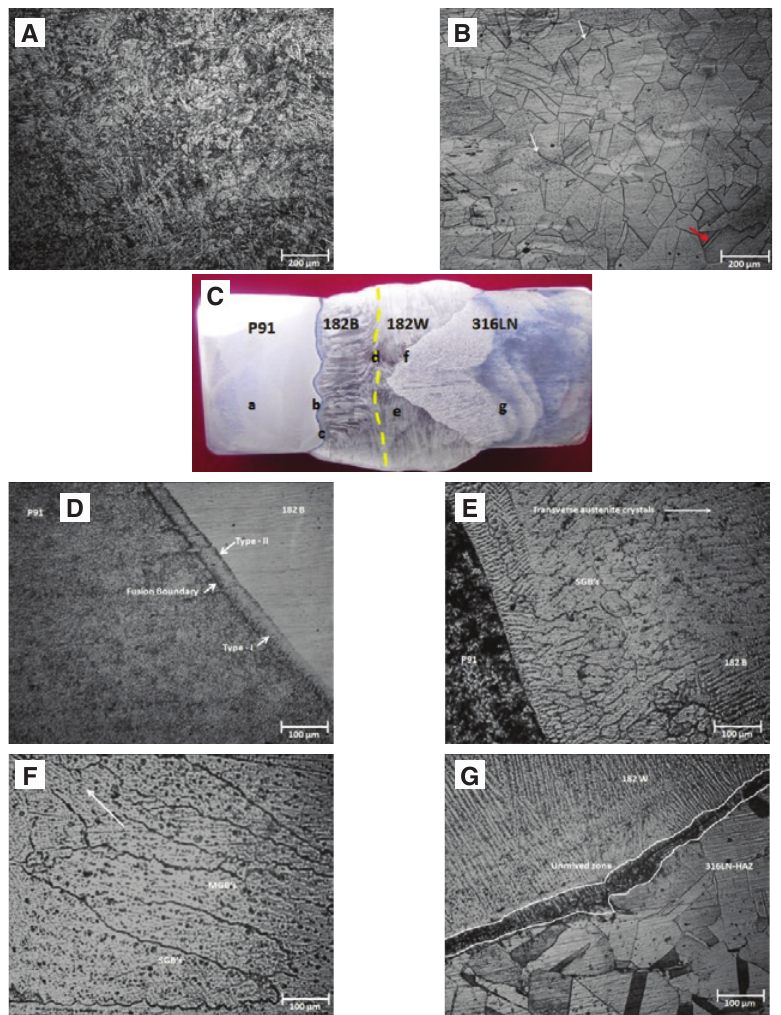
Figure 7: Optical micrographs of base metals and DMWJ. (A) Modified 9Cr-1Mo, (B) SS 316LN, (C) Macrograph of DMWJ, (D) Interface – P91-182B-1, (E) Interface – P91-182B-2, (F) 182 WM, (G) Interface-82/182